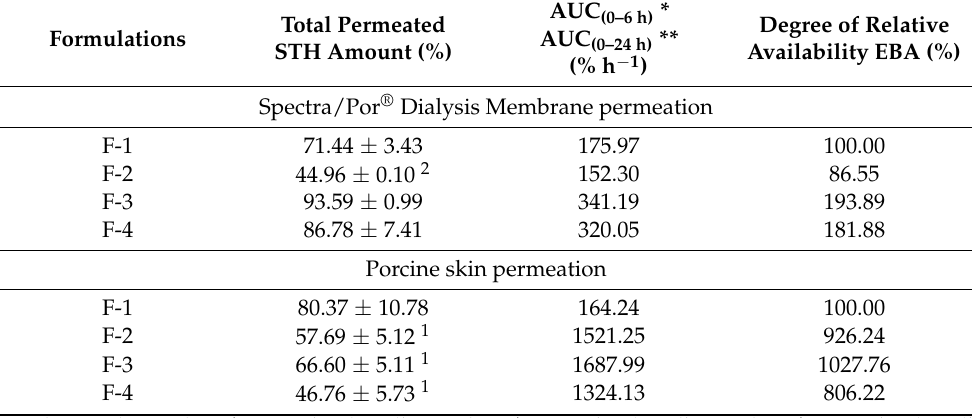
Table 2. Degree of STH permeation from hydrogels, area under the curve AUC (0 – 6 h) and relative availability of STH hydrogels without and with ALB when studying permeation through cellulose membrane and porcine skin.